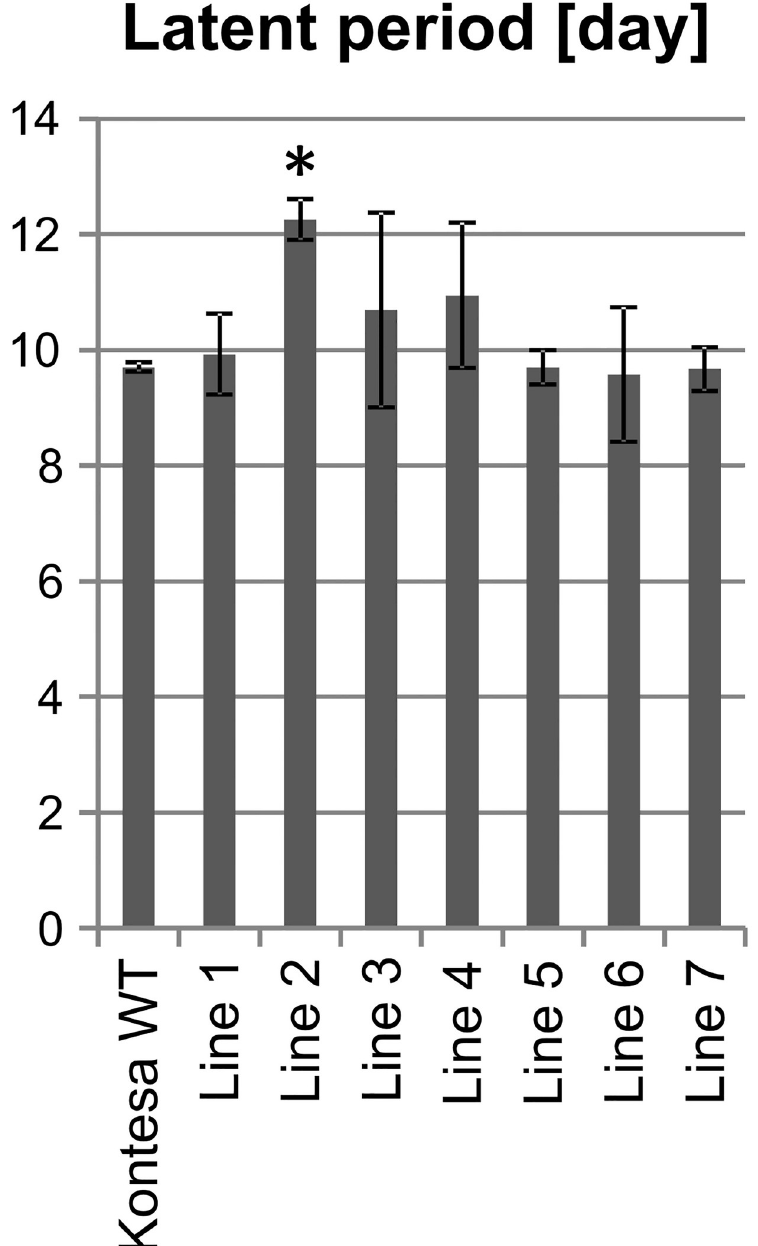
Fig 7. Latent period of P . triticina development on flag leaves of non-transgenic wheat cultivar Kontesa and 6 transgenic lines overexpressing TaWAK6 gene 16 days post inoculation with P . triticina . The data represent mean values with standard deviations; the asterisk indicates p < 0.05 using the ANOVA test followed by LSD post-hoc test (STATISTICA 10, StatSoft). The percentage of infection sites with uredinia showed a medium correlation with the uredinium size r = 0.65 (p � 0.005) and the latent period r = 0.62 (p � 0.05) indicating that S S inoculation of transgenic TaWAK6 plants led to fewer uredinia, which were smaller and with longer development. The average uredinium size on the flag leaf was strongly correlated